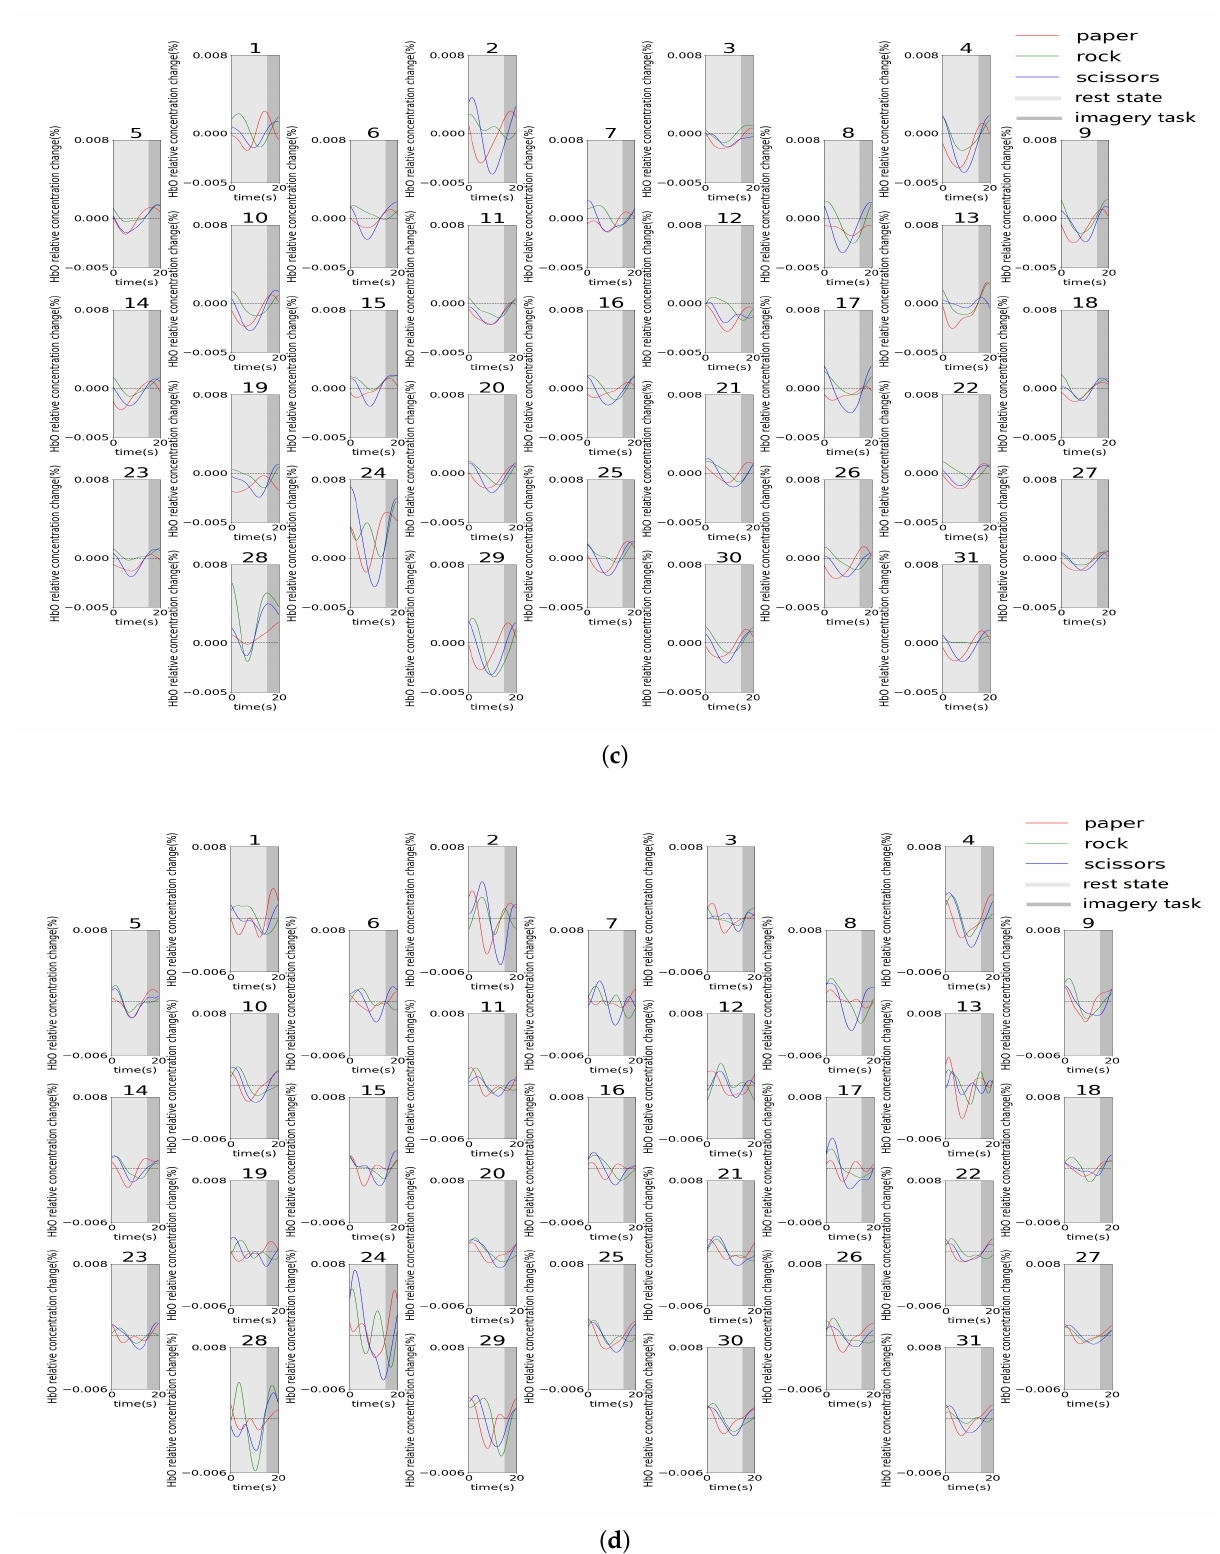
Figure 8. The averaged responses for the different tasks among all subjects after four kinds of data preprocessing. ( a ) The averaged responses after Z-normalization, ( b ) The averaged responses after Max-min normalization, ( c ) The averaged responses after FIR band-pass filter, ( d ) The averaged responses after Butterworth band-pass